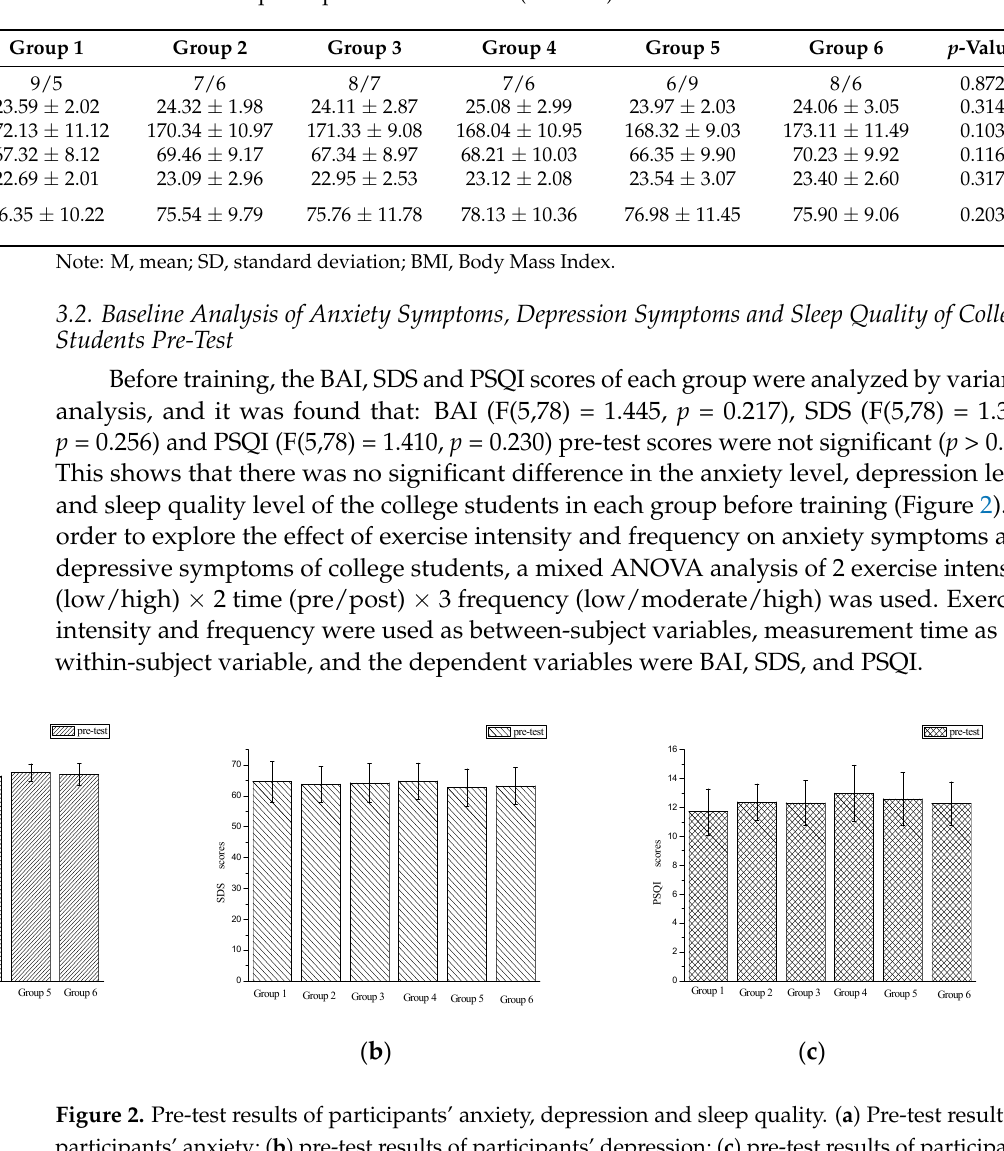
Table 1. Statistics of participant characteristics (M ± SD).